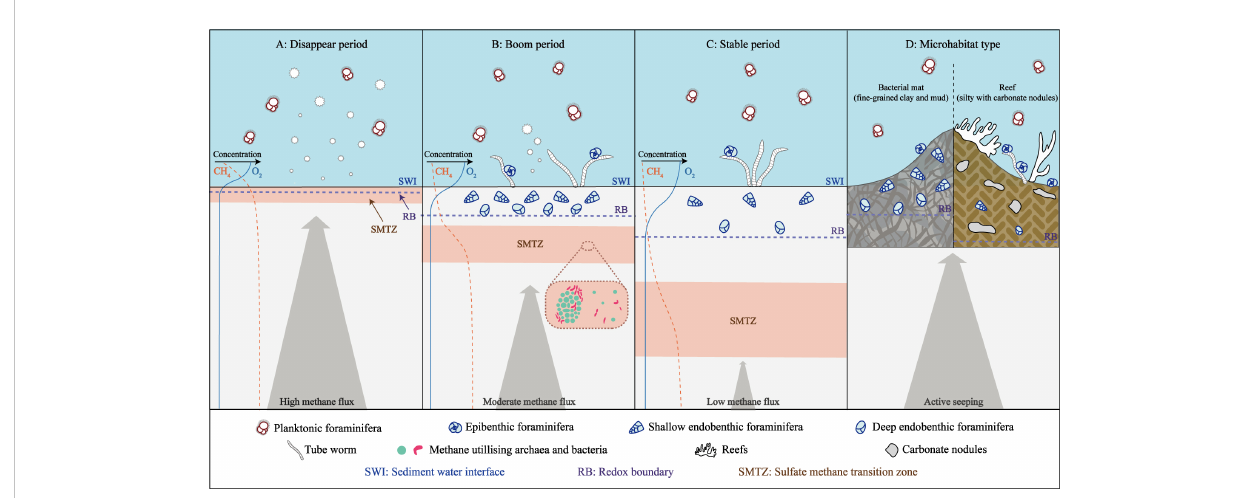
FIGURE 2 Living foraminiferal assemblages associated with methane seepages (after Borowski et al., 1996; Consolaro et al., 2015; Li et al., 2021). (A) Disappear period of benthic foraminifera during times of high methane fl ux. (B) Boom period of benthic foraminifera during times of moderate methane fl ux. (C) Stable period of benthic foraminifera during times of low methane fl ux. (D) Benthic foraminiferal assemblages in different seep